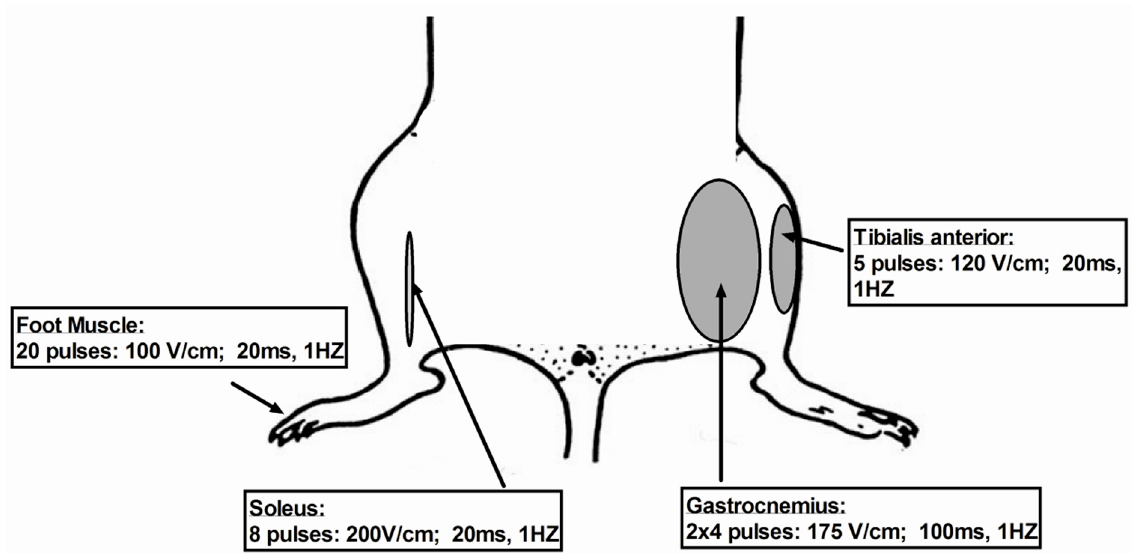
Figure 3. Schematic representation of electroporation parameters.